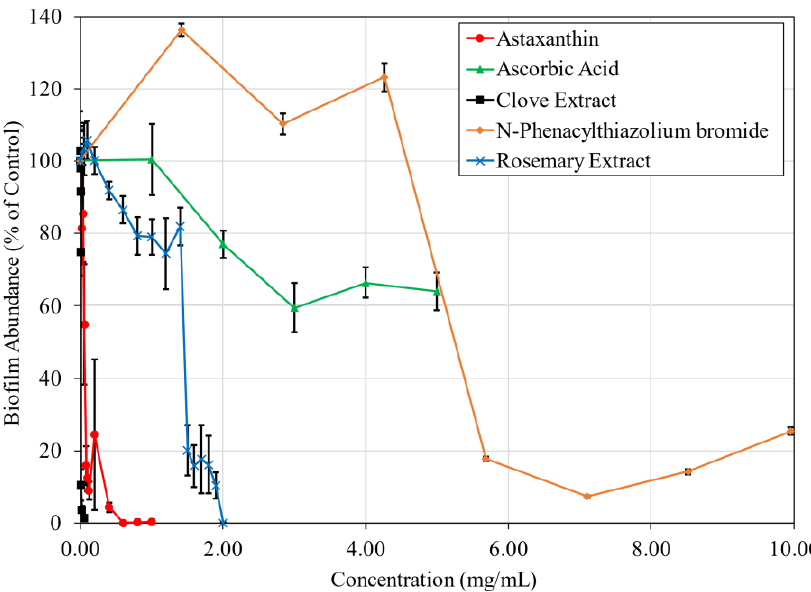
Figure 1. Biofilm Inhibition. Effect of test compounds on S. aureus biofilm formation provoked by 0.5 mg/mL of glucose-keratin. Biofilm assayed after 48 h of growth under static conditions. n = 8. Mean ± standard deviation.